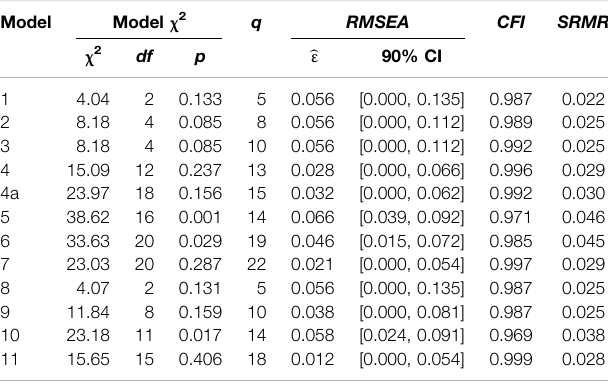
TABLE 4 | Global fi t statistics for path models of Exercise Change. Model Model χ 2